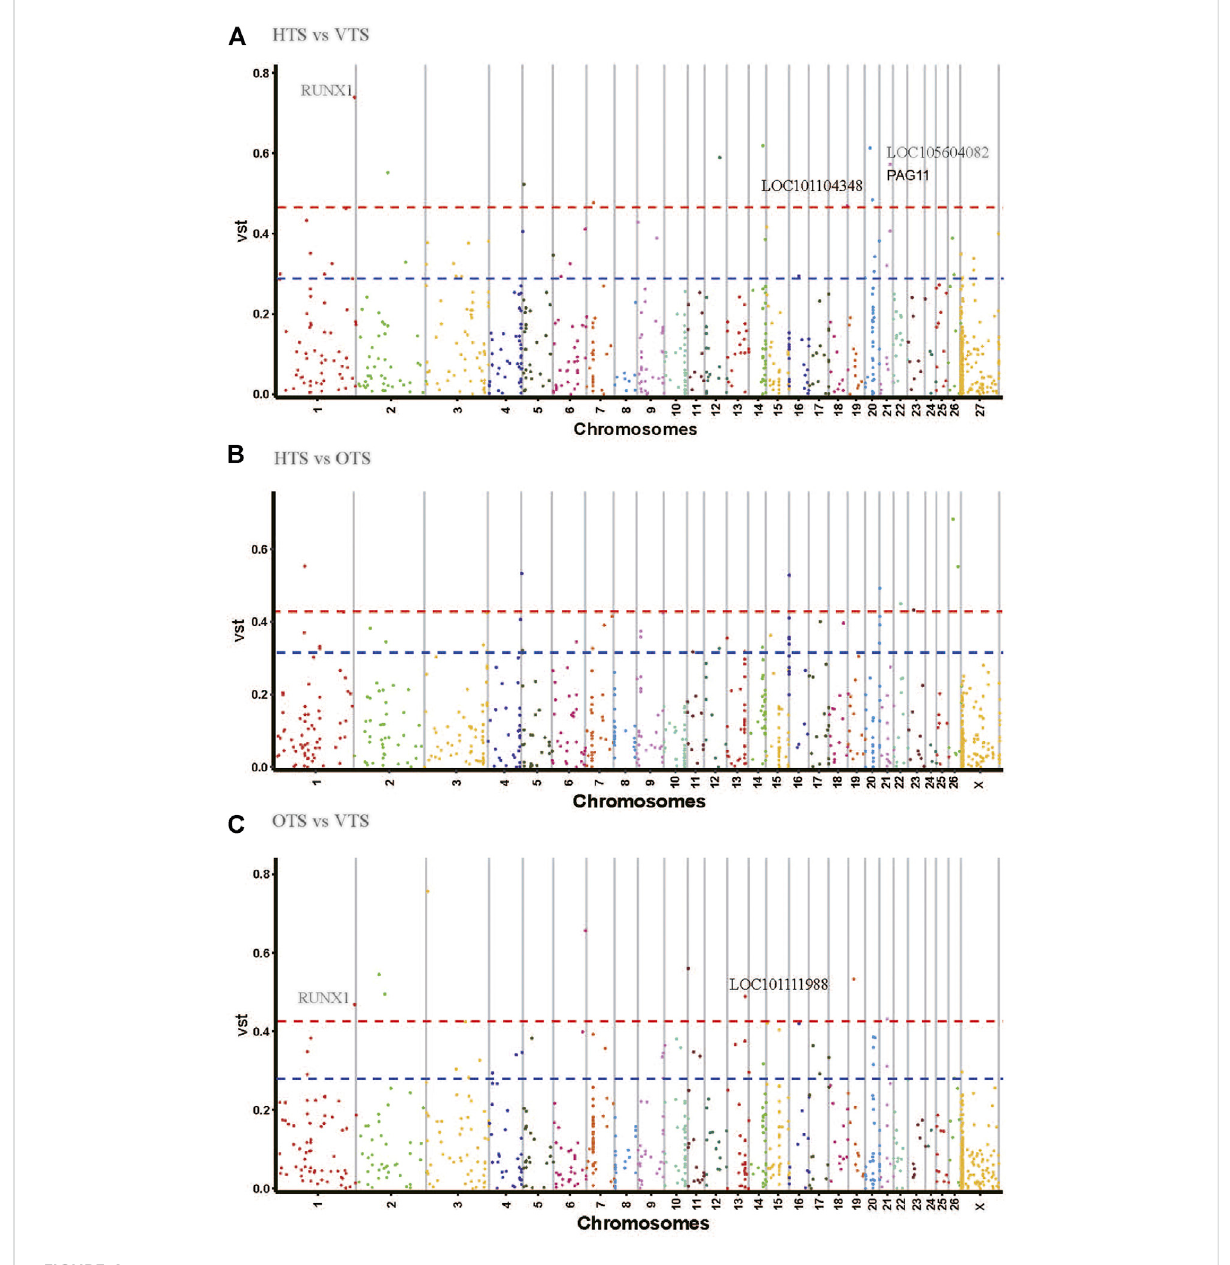
FIGURE 4 Genome wide Vst value plots for CNVRs in three population